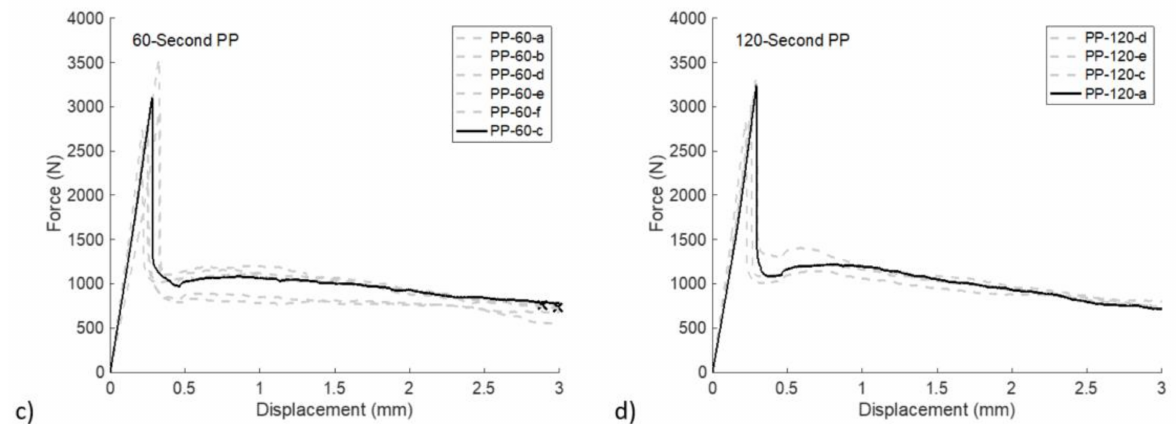
Figure A3. Force-displacement curves for all PP specimens tested in flexure at ( a ) 0 s of treatment time, ( b ) 30 s of treatment time, ( c ) 60 s of treatment time, and ( d ) 120 s of treatment time.